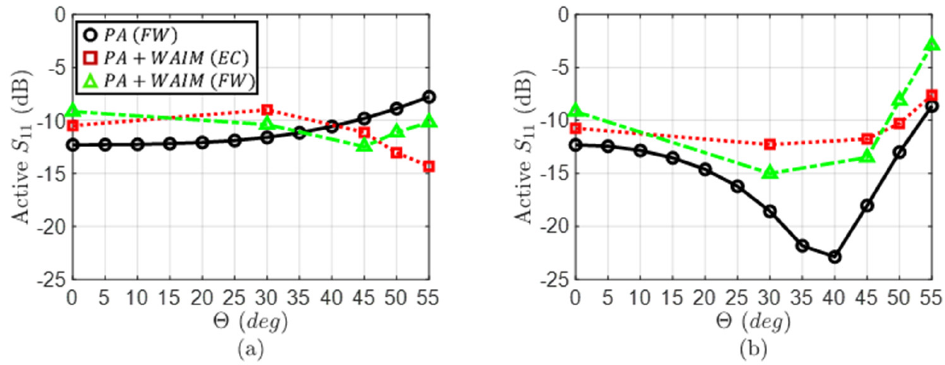
Figure 9. Active reflection coefficient at f = 18 GHz limiting d WAIM : ( a ) H-plane and ( b ) E-plane ; phased array ( PA ) and full-wave ( FW ).